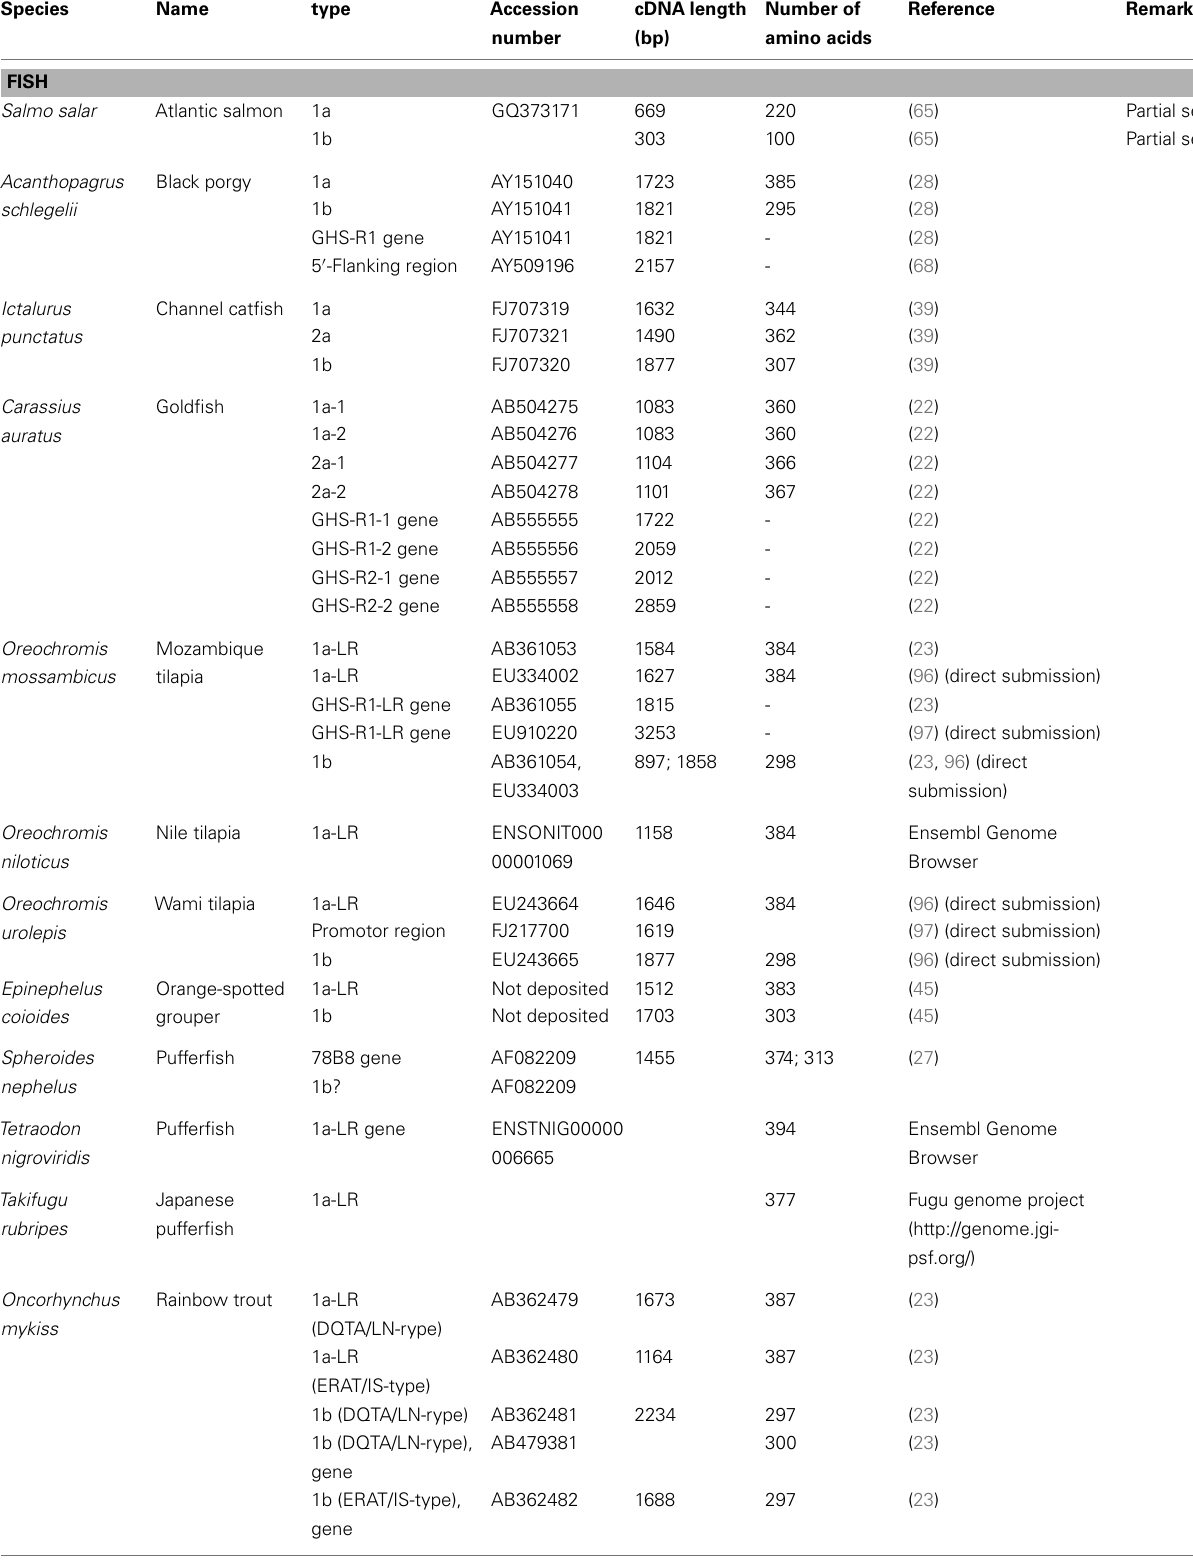
Table 1 | Ghrelin receptor and ghrelin receptor-like receptor in